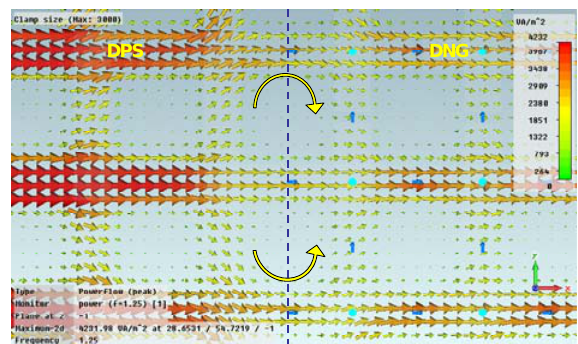
(a) Vortexlike power flow at the DPS/DNG interface in 1.25GHz near the interface in the black dashed rectangle Ⅰ region in Figure 1.